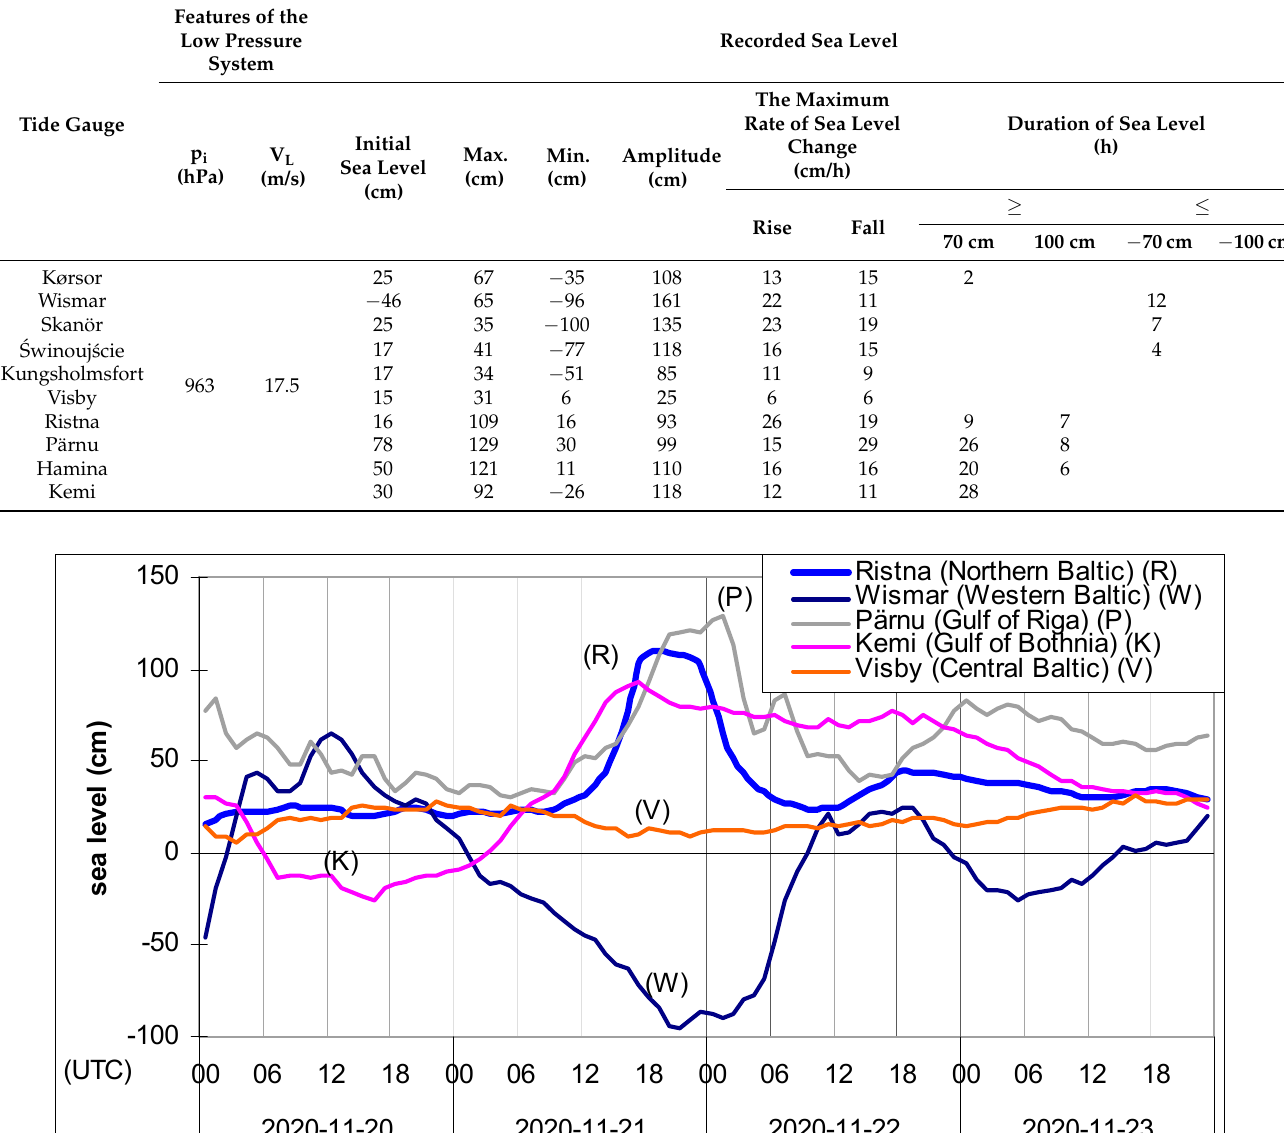
Recorded Sea Level